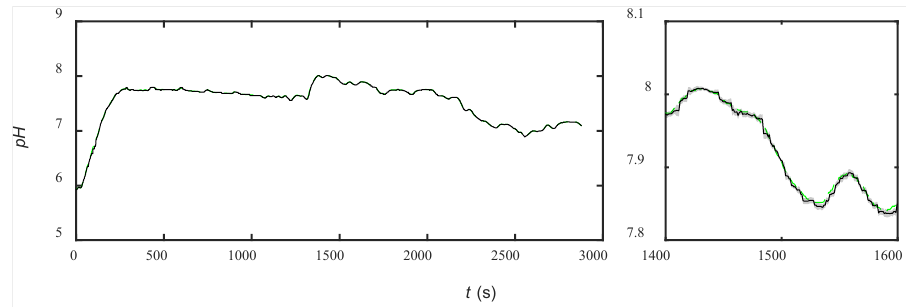
Figure 5. Sample results of NGBoost for the pH sensor AIT202 (bands delimited by 2σ).